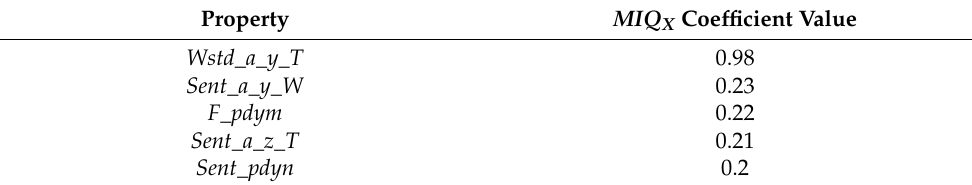
Table 1. The most significant signal features for assessing pump wear condition.